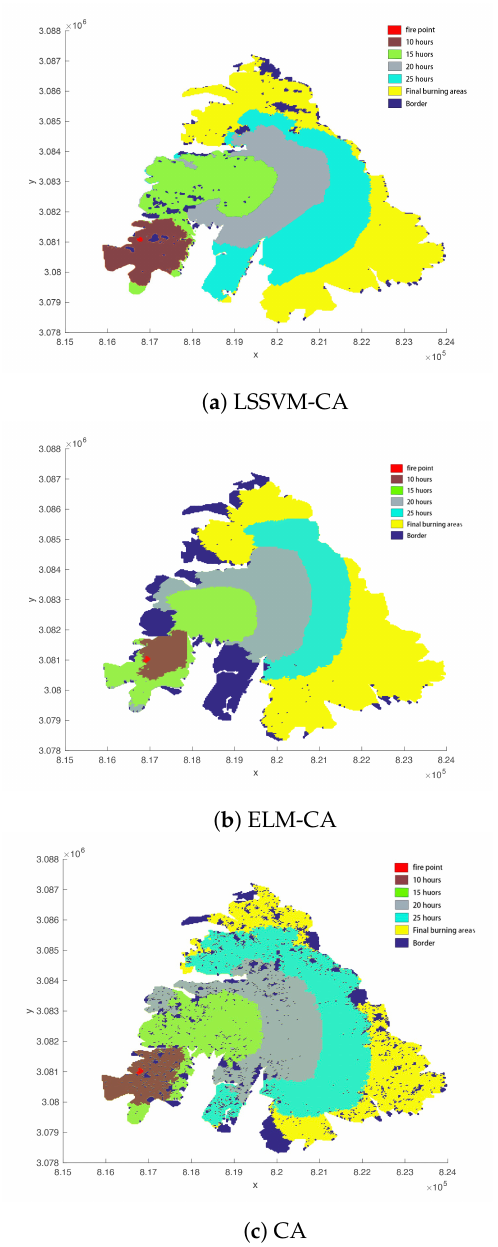
Figure 5. Simulation of the entire forest fire process in 5 h